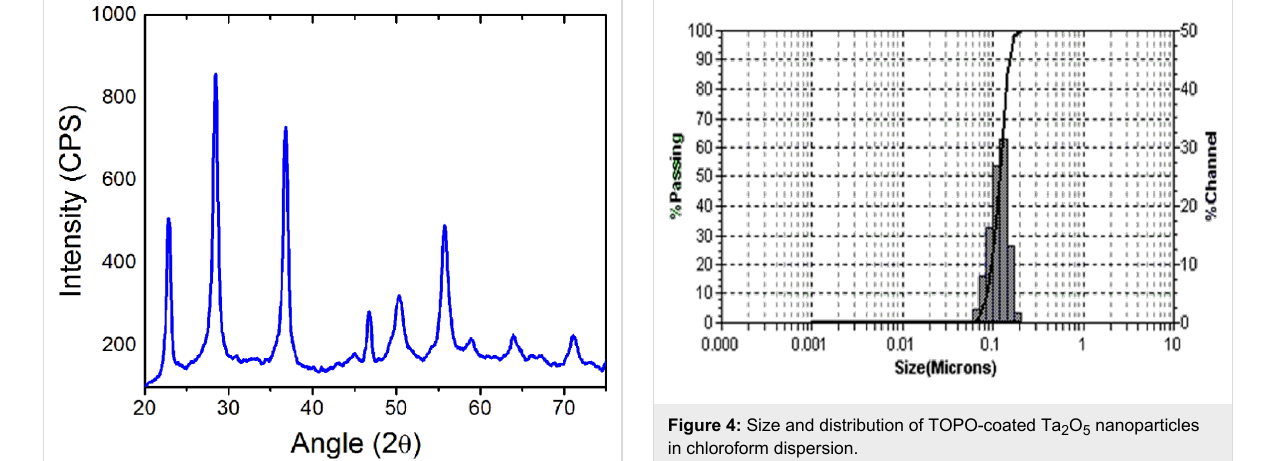
Figure 4: Size and distribution of TOPO-coated Ta 2 O 5 nanoparticles in chloroform dispersion.